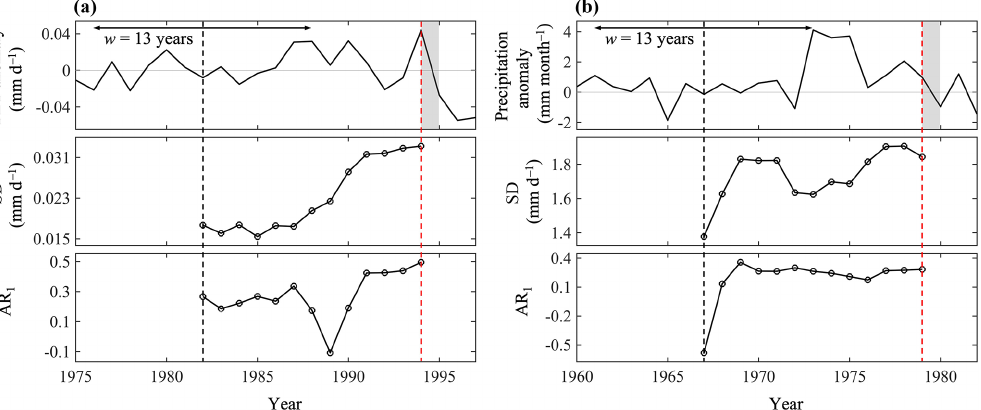
Figure 2. Time series of anomalies, AR 1 , and SD of global (a) PET and (b) precipitation. The horizontal lines with arrows show the width of one moving window (13 years), the vertical dashed red lines represent critical transitions, and the gray bands represent the transition